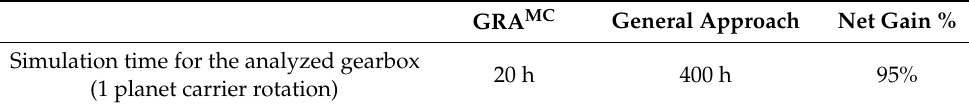
Table 6. Comparison of the computational effort between a standard and the newly implemented remeshing